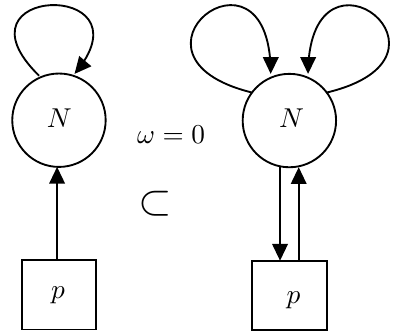
Figure 3. The Hanany-Tong vortex moduli space Lagrangian V N,p ⊂ M N,p